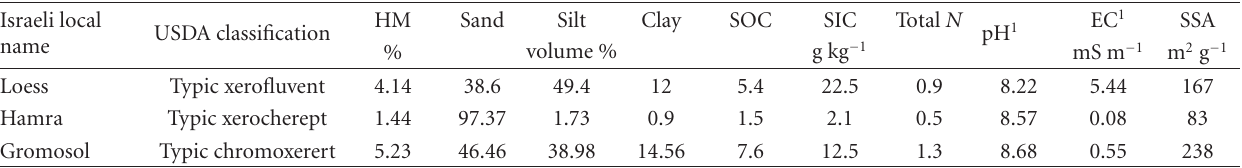
Table 1: Major soil